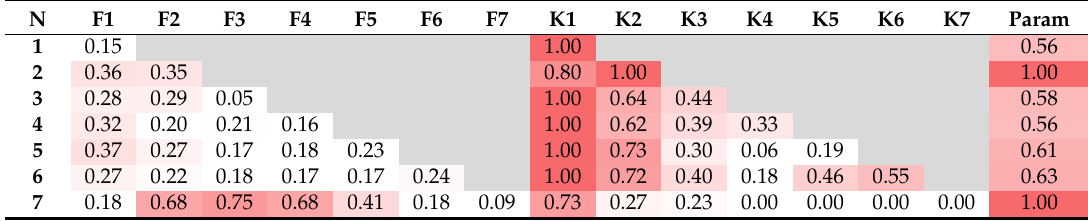
Table 2. Relative importance of 𝐻𝑃𝑠 = {𝐹 (cid:3036) ,𝐾 (cid:3036) ,𝑃𝑎𝑟𝑎𝑚𝑠 (cid:3036) } (cid:3036)(cid:2880)(cid:2869)(cid:2875) as individual predictors of CNN performance. The importance range (0–1) is coded with a color gradient, highlighting the most important features (dense red).